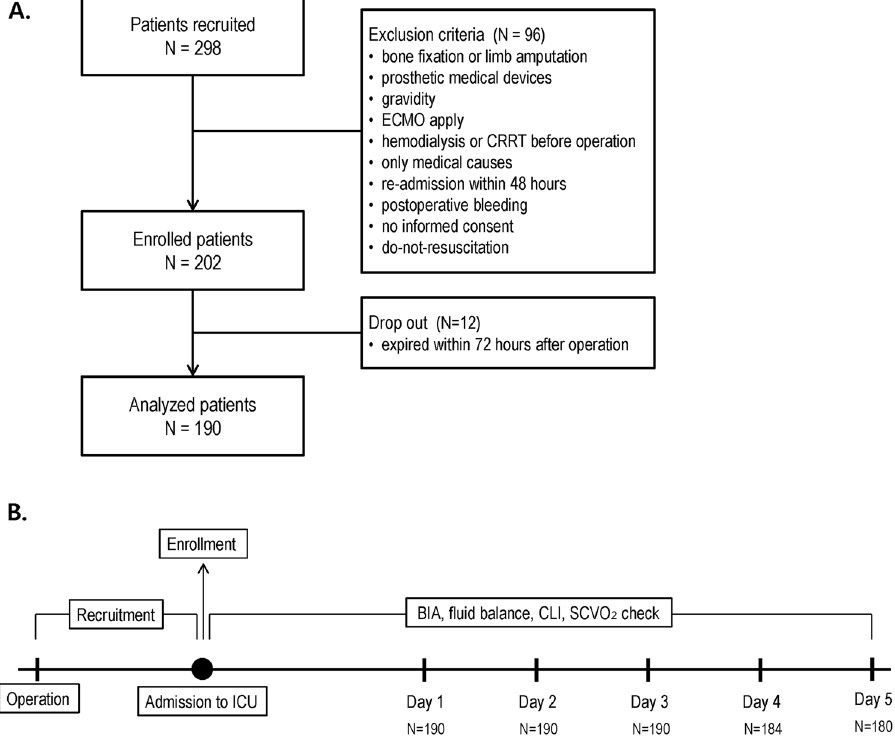
Figure 1. ( A ) Flow chart of patient enrollment, ( B ) flow diagram of study